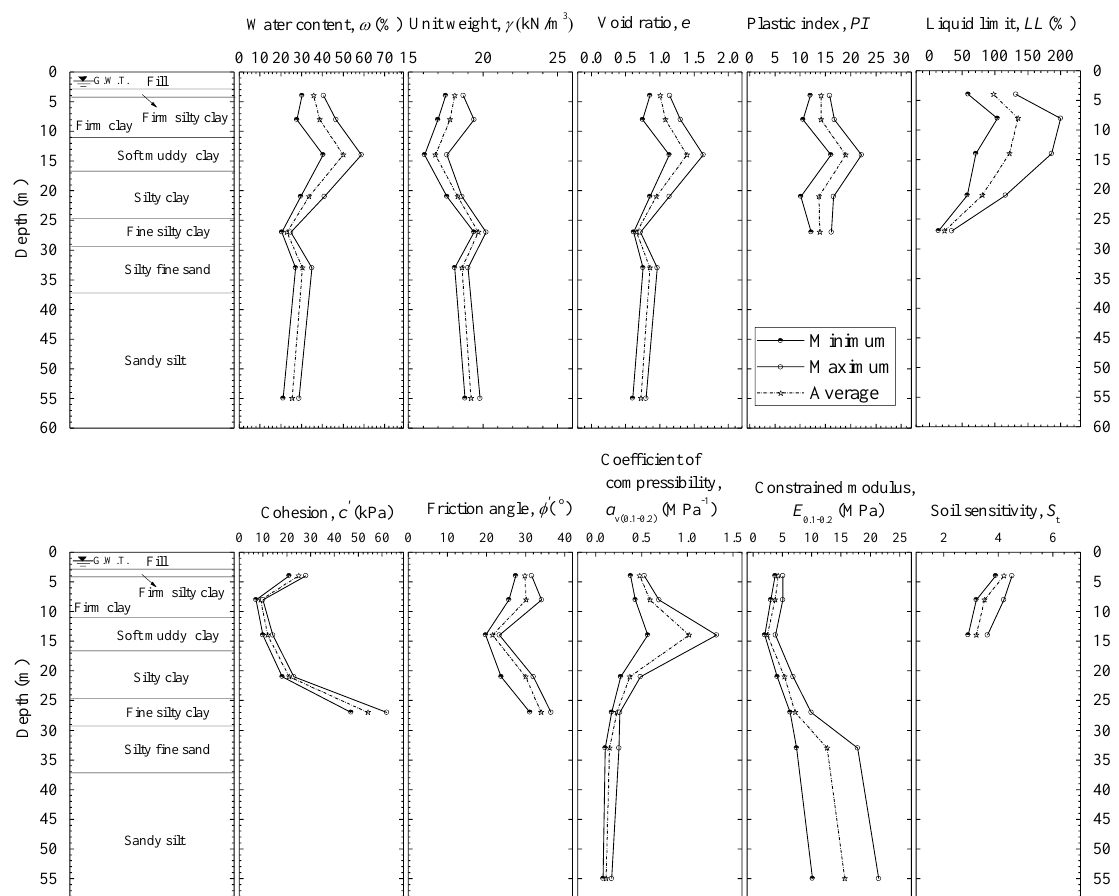
Figure 4. Soil profiles and material properties at the site.